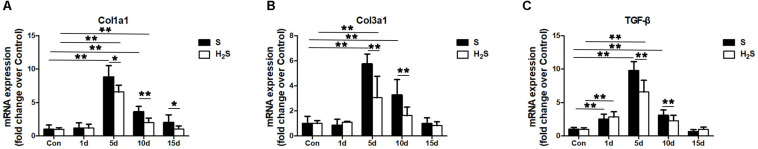
Effect of H2S donor on the expression of Collagen and pro-fibrotic cytokines in the GM post-injury. Control, uninjured skeletal muscle; S, muscle contusion group injected intraperitoneally with saline; H2S, muscle contusion group injected intraperitoneally with NaHS. (A) The expression of Collagen I; (B) The expression of Collagen III; (C) The expression of TGF-β. All data represent means ± SD, ∗P < 0.05, ∗∗P < 0.01, n = 8.